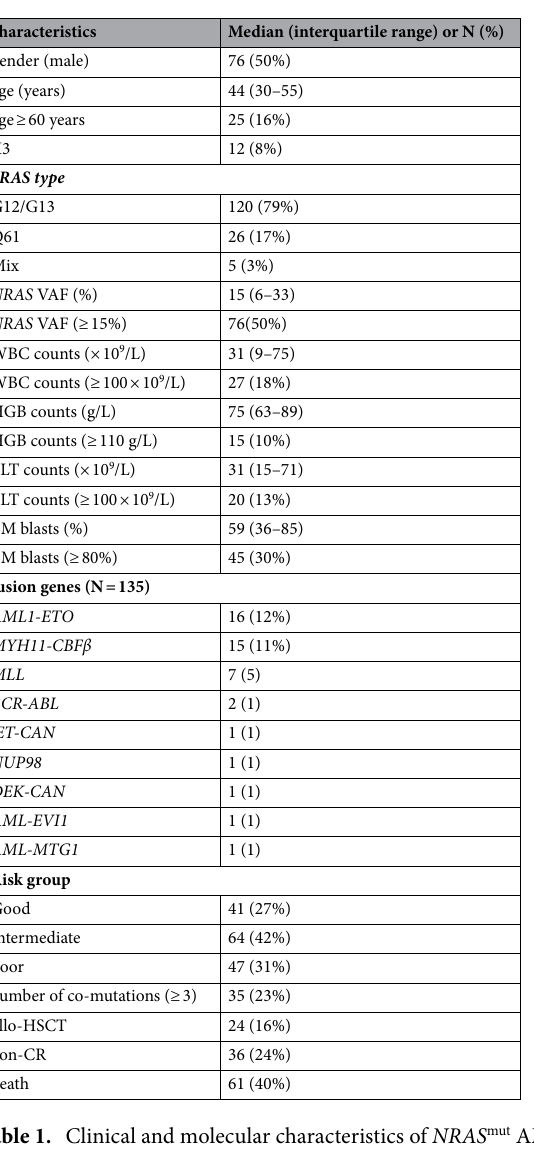
Table 1. Clinical and molecular characteristics of NRAS mut AML. VAF Variant allele frequency, WBC white